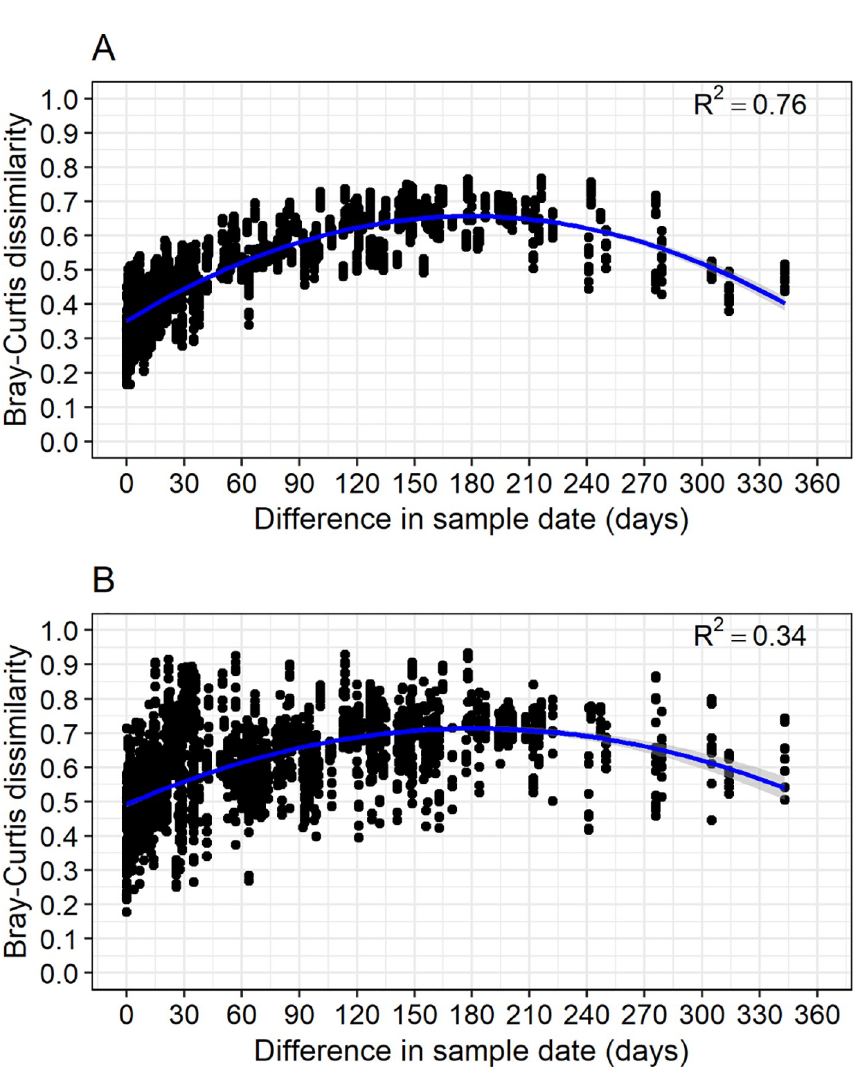
Fig 5. Temporal patterns in bacterioplankton beta diversity measured using Bray-Curtis dissimilarity. Relationships between (A) particle-associated and (B) free-living dissimilarities and interval of time between sample dates. Points represent pairwise dissimilarities calculated from bacterioplankton assemblages collected between 1 and 343 days apart.